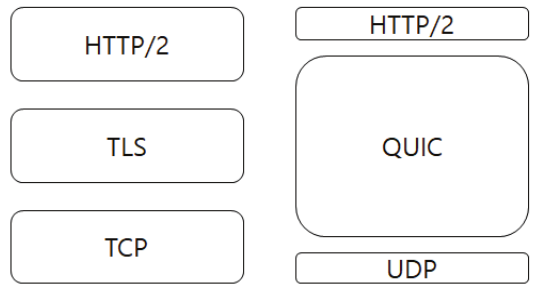
Figure 2. Architecture of the Quick UDP Internet Connections (QUIC) protocol.